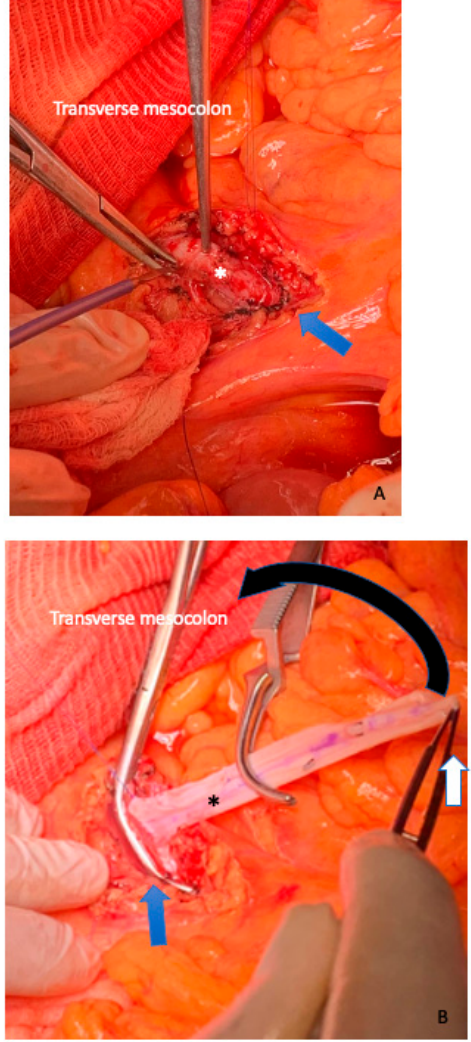
Figure 9. Venous jump graft technique. ( A ) Identification of the superior mesenteric vein (white asterisk) at the root of the mesentery (blue arrow). ( B ) Anastomosis between the superior mesenteric vein (blue arrow) and cadaveric iliac venous bank graft (black asterisk). The white arrow marks the distal segment that will be anastomosed with the portal vein or a collateral vessel. The jump graft is accessed through the transverse mesocolon (black arrow).